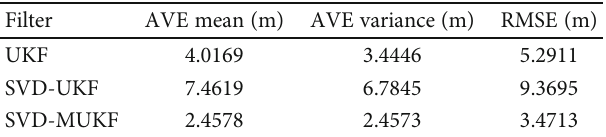
Figure 9: AVE with uniform acceleration curve motion (displacement). Table 5: Mean, variance, and RMSE of algorithm displacement data.